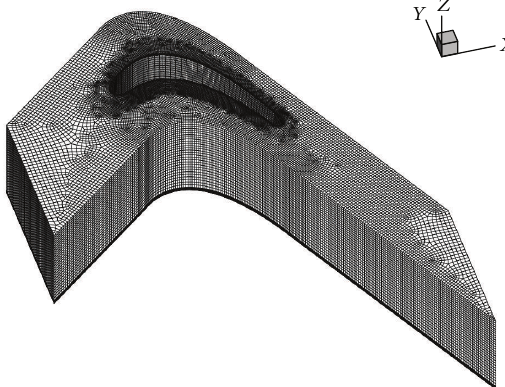
Figure 6: Computational